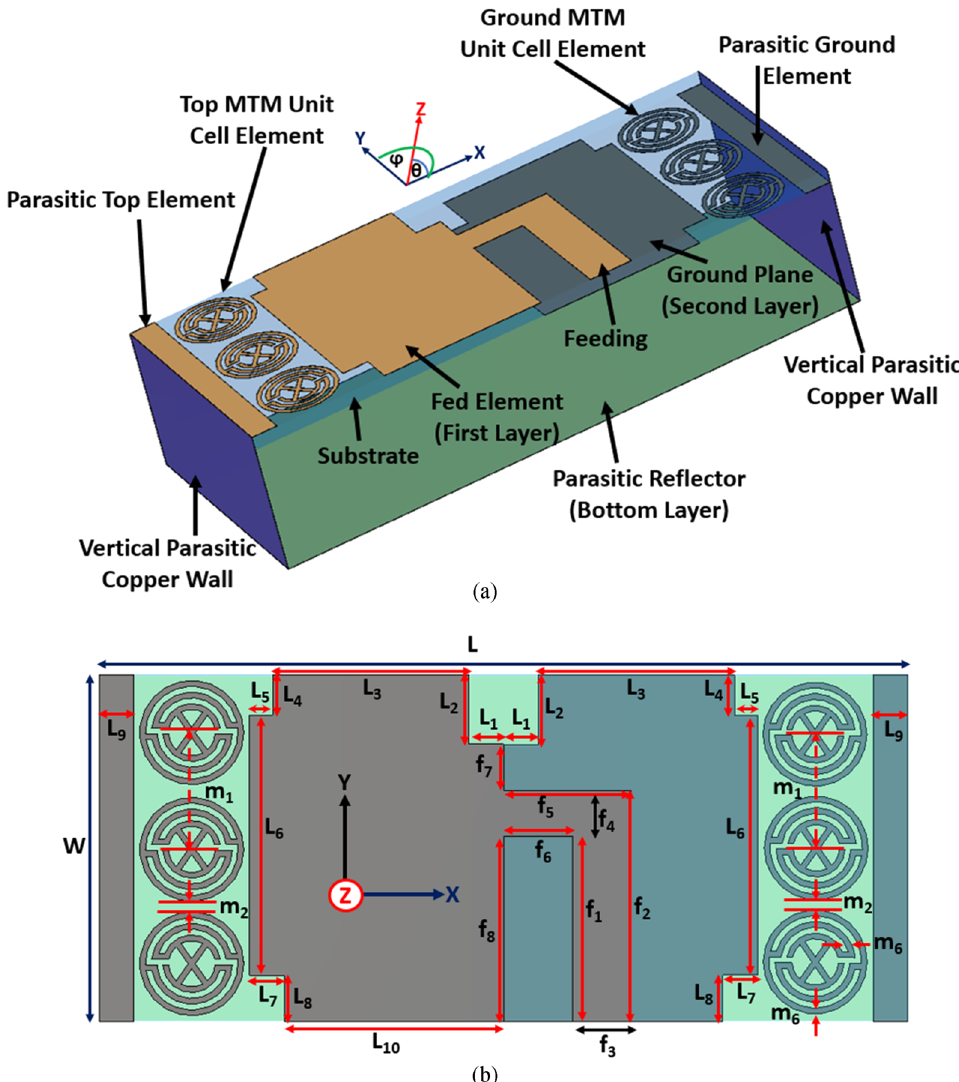
Figure 1. Schematic profile of the proposed MTM-loaded 3-D antenna. ( a ) Perspective view. ( b ) Top view. Dimensions (mm): L = 70, W = 30, L1 = 3, L2 = 6, L3 = 17, L4 = 3.5, L5 = 3, L6 = 22.5, L7 = 3, L8 = 4, L9 = 3, f1 = 16, f2 = 20, f3 = 5, f4 = 4, f5 = 11, f6 = 6, f7 = 4, f8 = 16, m1 = 10, m2 = 1, m6 =